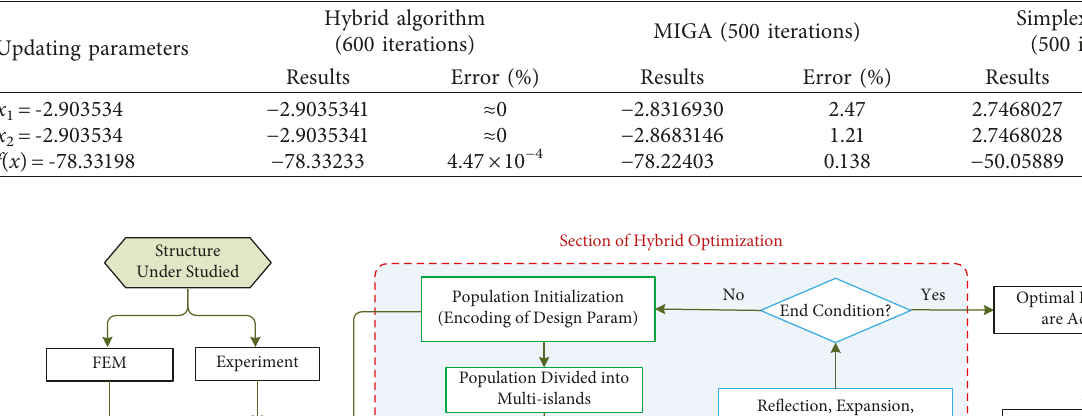
Table 3: The results of the hybrid algorithm with more